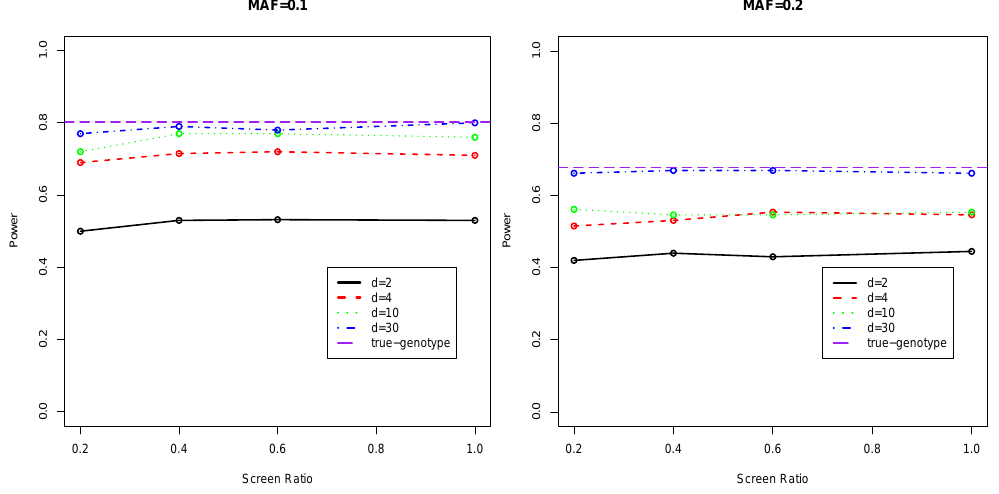
Figure 2. Testing Powers of Continuous Phenotype with Covariates